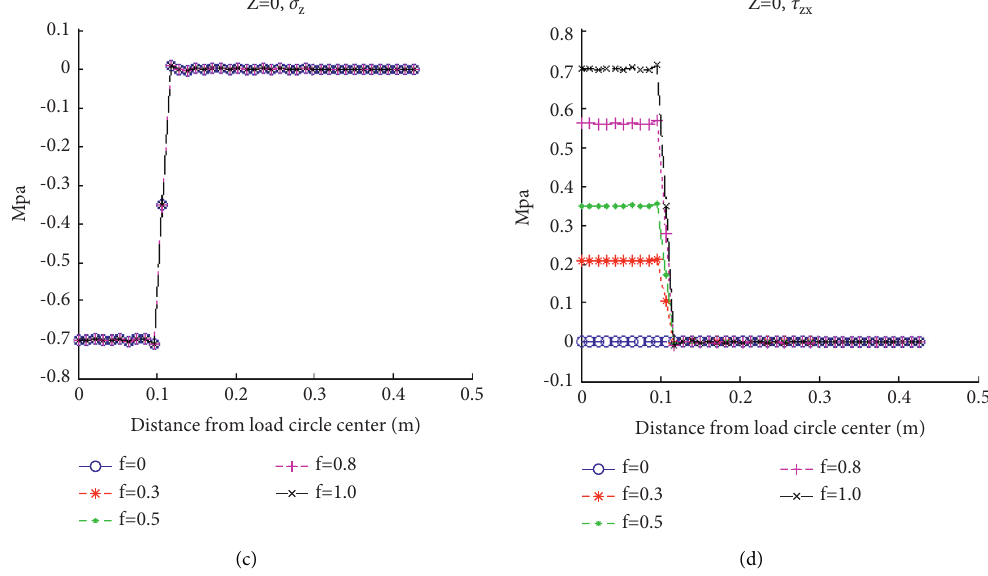
Figure 10: Calculation results of normal stress and shear stress of structure in x -axis ( z � 0). (a) Calculation results of normal stress σ structure in x -axis ( z � 0). (b) Calculation results of normal stress σ y of structure in x -axis ( z � 0). (c) Calculation results of normal stress σ Z of structure in x -axis ( z � 0). (d) Calculation results of shear stress τ zx of structure in x -axis ( z � 0).